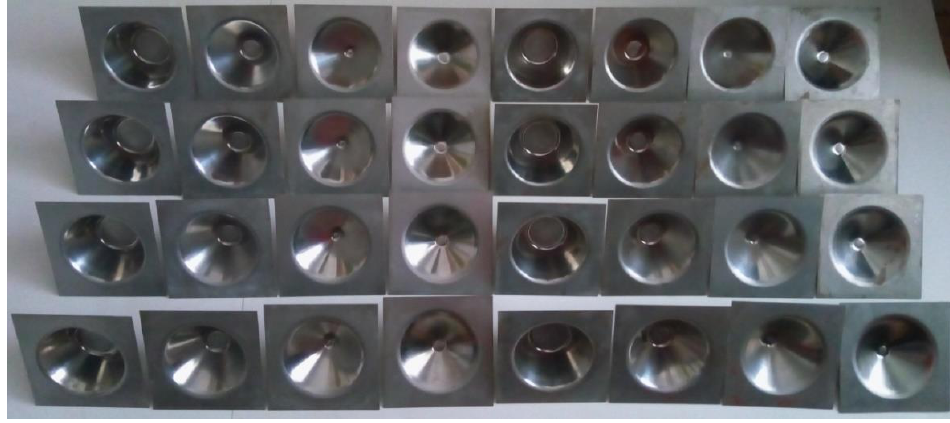
Figure 16. Parts machined according to array of experiments, reprinted with permission from ref. [5]. The replicas are used to verify the repeatability of the circumferential hammering SPIF process. The replicas were machined in the same random order generated by Minitab